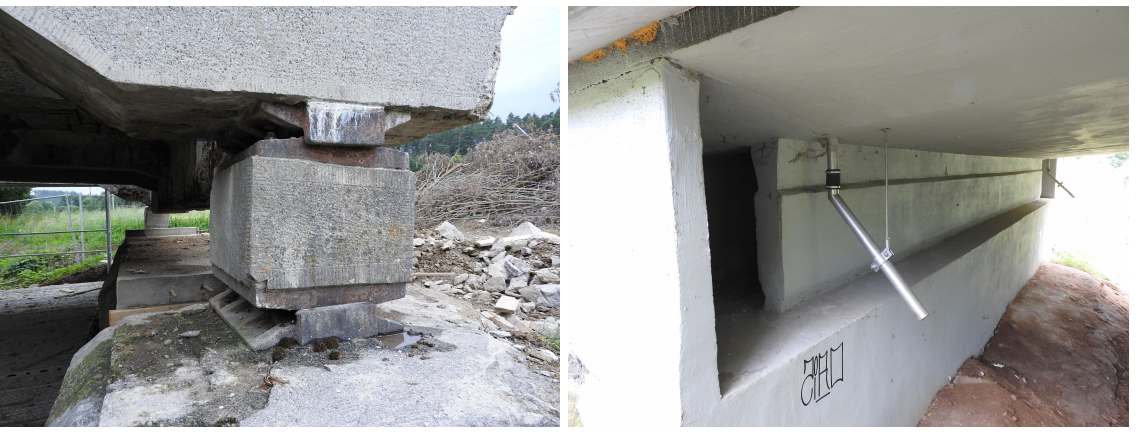
Figure 8. Pendulum supports (left – bow-string bridge at Bačkovice, 1929; right – end of the deck of the arch bridge at Přibyslav,